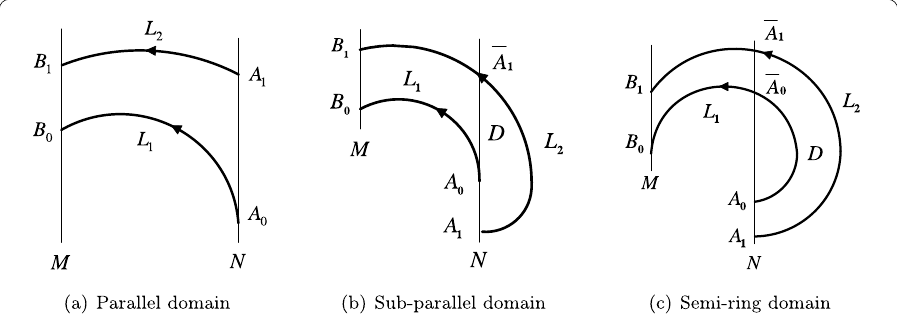
Figure 4 The illustration for three categories of Bendixson domain. A 0 is a tangent point in ( a ) and ( b ), while B 0 is a tangent point in ( c